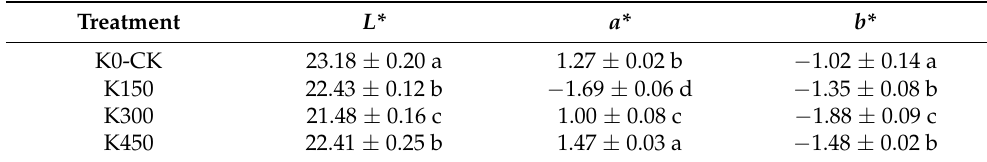
Figure 4. ( A ): Tartaric acid content; ( B ): malic acid content. Different lowercase letters indicate sig- significant differences among the treatments (Duncan’s Multiple Range Test, p < nificant differences among the treatments (Duncan’s Multiple Range Test, p < 0.05).